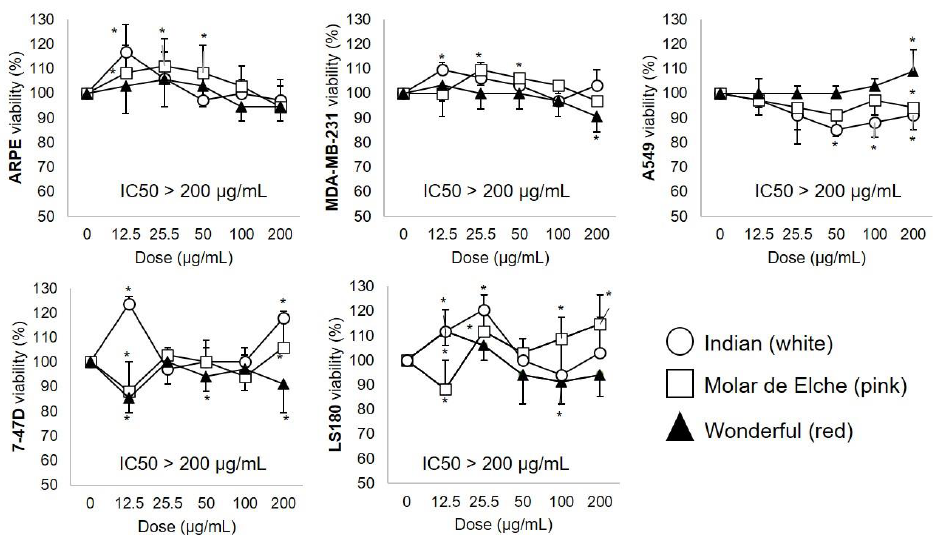
Figure 5. MTT cell viability assay after exposure to graded doses (0–200 µ g.mL − 1 in DMSO; 48 h) of PMG fruit extracts (red, pink, white). Data are expressed as mean (triplicate) ± SD. * Statistically different ( p < 0.05; one-way ANOVA, Tukey’s post hoc test) vs. unstimulated (0 µ g.mL − 1 ) cells; human normal retinal (ARPE-19; CRL-2302TM), breast MDA-MB-231; HTB-26TM), alveolar (A549; CCL- 185TM) and colorectal Duke’s type II (LS180; CL -187TM) adenocarcinomas, breast ductal carcinoma (T-47D; HTB-133TM) cell lines (ATCC ® , Rockville, MD, USA). Despite an apparent red > pink > white trend (all but A549 cells; Figure 5), all PMG